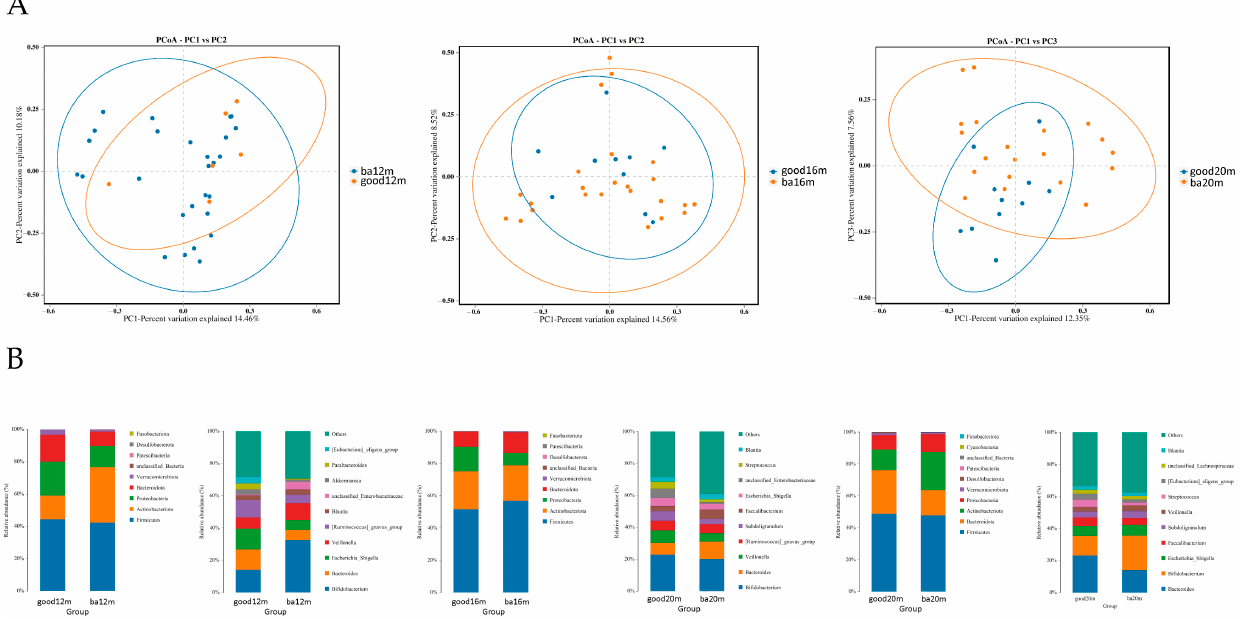
Figure 4. Gut microbiota community structure in each group varied by language composite score at different sampling times. ( A ) Bray–Curtis distances displayed by PCoA plots at 12 months, 16 months and 20 months; ( B ) relative abundance at phylum level and genus level at 12 months, 16 months and 20 months. Figure legend: bm, breast milk; ba, below average; m, months.